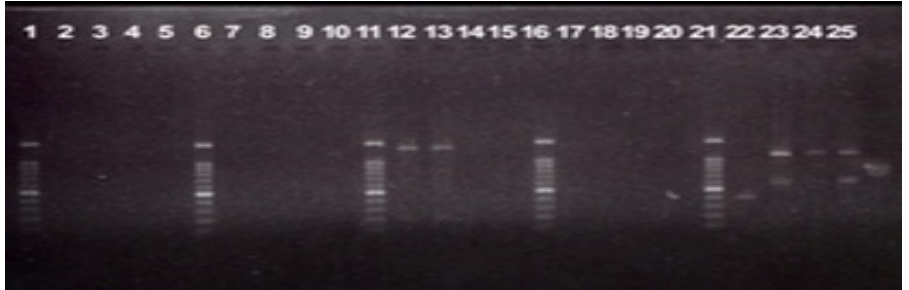
Fig. 1: Electrophoresis results of non-conjugated products obtained from RAPD-PCR Column 1: Marker, Columns 2 to 5: Primer OPQ14, Column 6: Marker, Columns 7 to 10: OPQ17, Column 11: Marker, Columns 12 to 15: OPR12, Column 16: Marker, Columns 17 to 20: OPS03, Column 21: Marker, Columns 22 to 25: OPA11